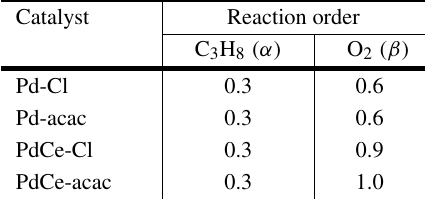
Influence of propane and oxygen partial pressures on the reaction rate in the absence of